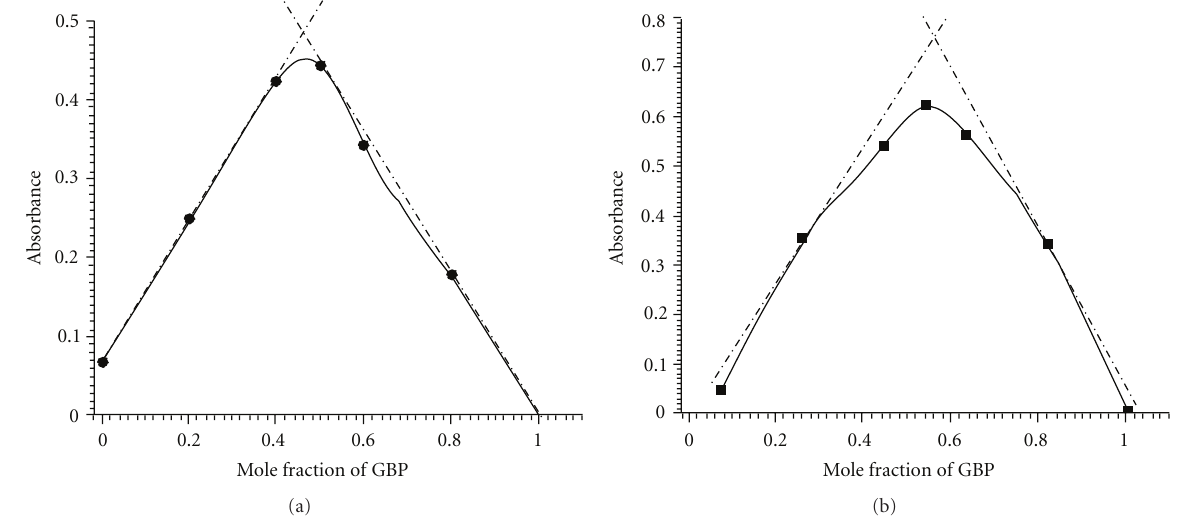
Figure 5: Job’s Continuous-variations plots (a) GBP + PA; (b) GBP + 2,4-DNP. Table 5: Method robustness and ruggedness.